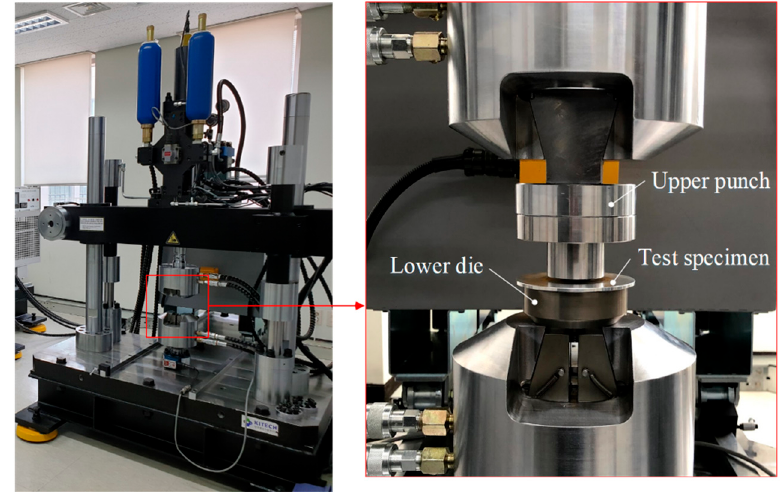
Figure 7. Experiment for measuring the joining force.